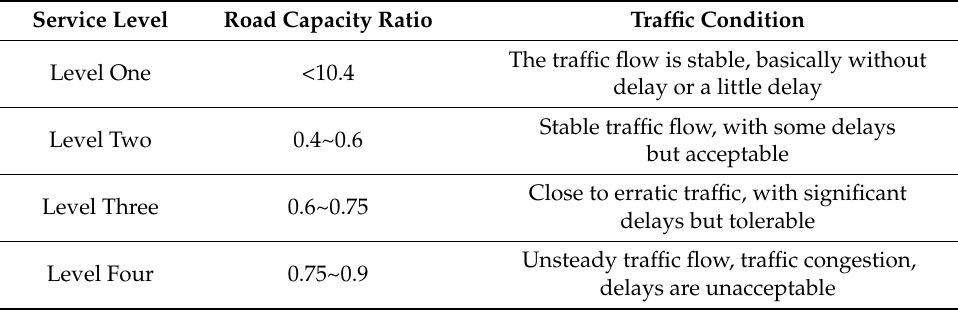
Table 7. Classification of traffic service level in China.